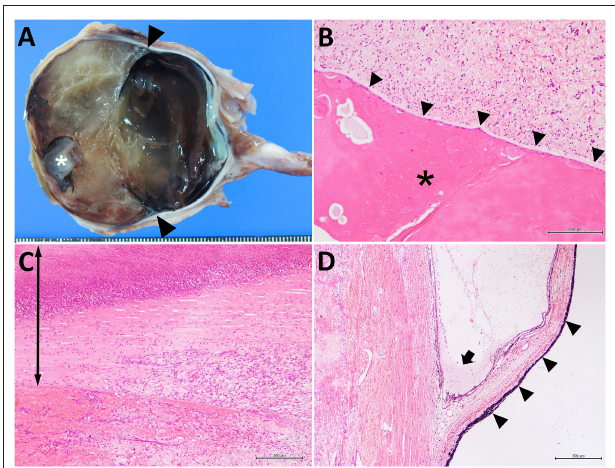
FIGURE 4 | The cut surface of the affected right eye (A) and the histological sections of the lens-like structure (B) , the thickened anterior structure (C) , and the iris (D) . In (A) a 1-cm-diameter, whitish, globular lens structure (asterisk) is located on the subcornea. The structures of the iris are present (arrowheads). Scale bar = 1mm. In (B) , marked degeneration of the lens (asterisk) is attached to the fibro-vascular tissues (arrowheads). In (C) , corneal tissue is thickened (arrow) and shows marked infiltration of neutrophils and fibroblastic cells (right-side). The surface is ulcerated and necrotic (upper region). The inner corneal epithelium cannot be identified. Hemorrhagic changes are also visible in the lower left-side of the photo (anterior chamber). In (D) , the atrophic iris (arrowheads) and ciliary body are seen. Exudate and some neutrophils are observed in the iridocorneal angle (arrow). (B) bar = 200 µ m; (C) bar = 200 µ m; (D) bar = 500 µ